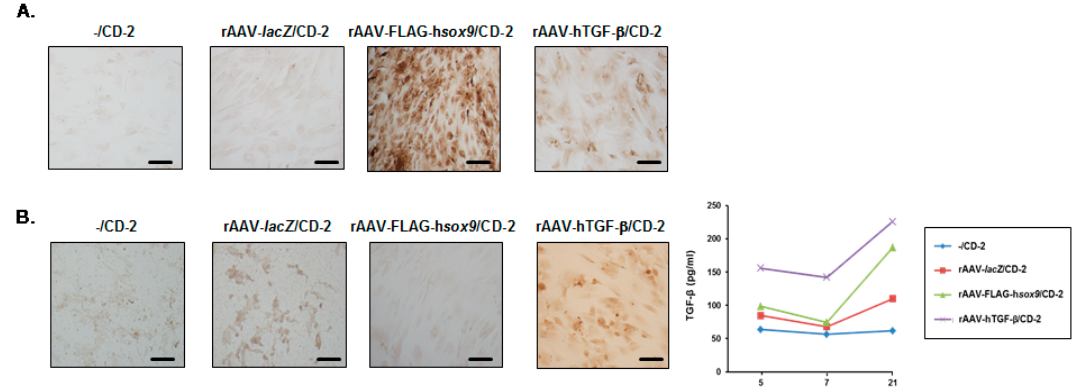
Figure 5. Detection of therapeutic (SOX9, TGF- β ) gene overexpression in hMSCs transduced with the rAAV / CD-2 system. The rAAV-FLAG-h sox9 , rAAV-hTGF- β , and rAAV- lacZ vectors (40 µ L each vector, 8 × 10 5 transgene copies) were formulated with CD-2 (40 µ L), and the resulting rAAV / CD systems (80 µ L, i.e., 8 × 10 5 transgene copies) were incubated with hMSCs (10,000 cells in 48-well plates; MOI = 80) for up to 21 days. SOX9 ( A ) and TGF- β ( B ) expression was examined using immunocytochemistry (A, B; magnification × 20; scale bars: 50 µ m; all representative data) and using specific (TGF- β ) ELISA (B). rAAV- lacZ / CD-2 and CD-2 lacking rAAV were used as controls. Table 2. Histomorphometric analyses in hMSCs transduced with the rAAV / CD-2 systems. Parameter -/CD-2 Type-II collagen Type-I collagen TGF- Type-X collagen Values are given as mean ± SD. All parameters are in % of positively (SOX9 + , TGF- β + , type-II + / -I + / -X + collagen) stained cells to the total cell numbers. Statistically significant relative to a - / CD-2, b rAAV- lacZ / CD-2 and c rAAV-FLAG-h sox9 .